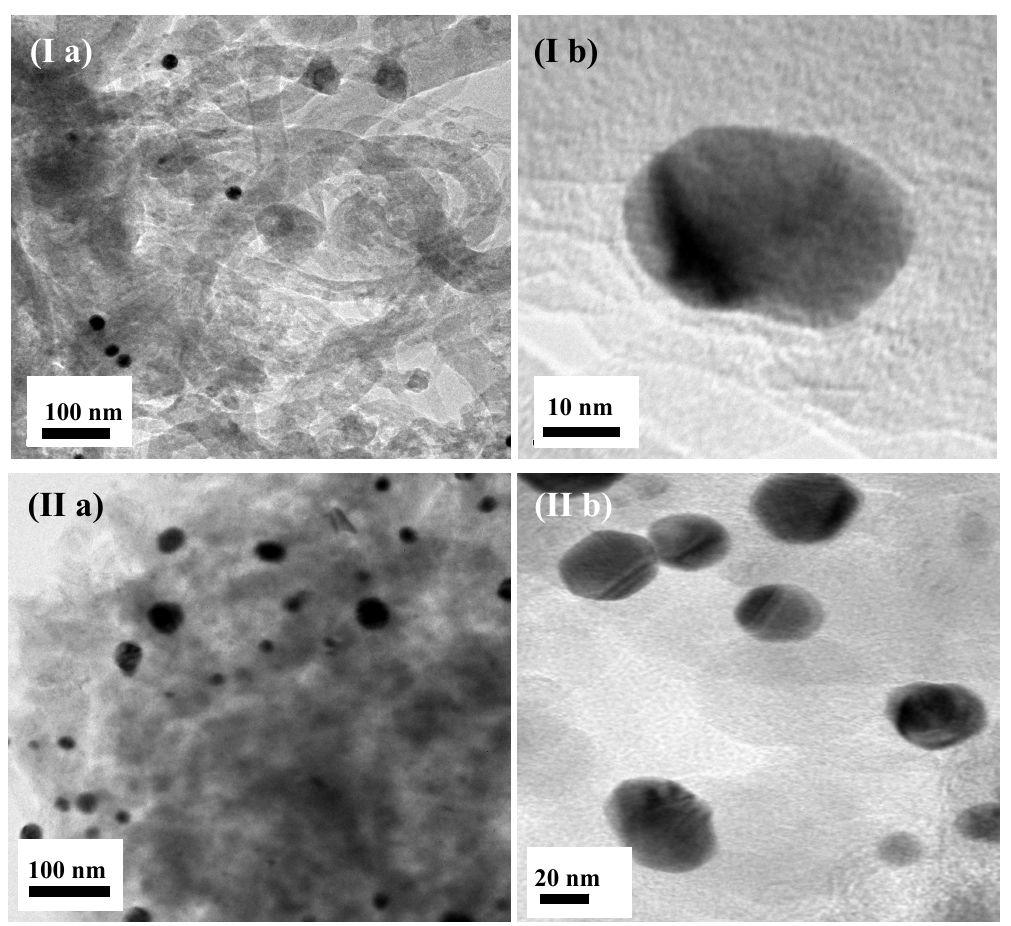
Figure 8. Representative ( a ) low and ( b ) high magnification TEM micrographs associated to the reduced samples ( I ) Au/CNF-F-IMP and ( II ) Au/CNF-F-SGT.